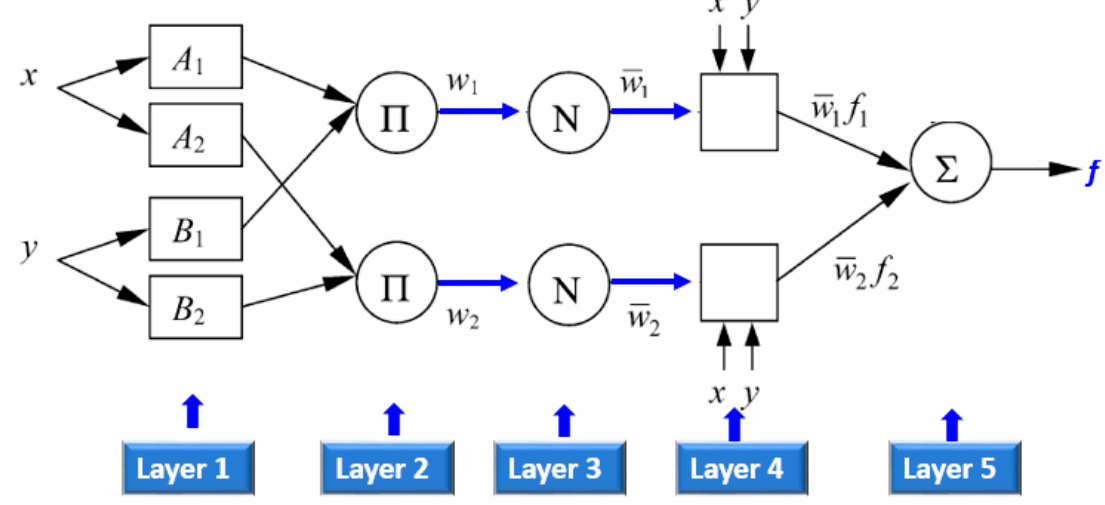
Figure 4. Basic structure of ANFIS with a two rule Sugeno system.